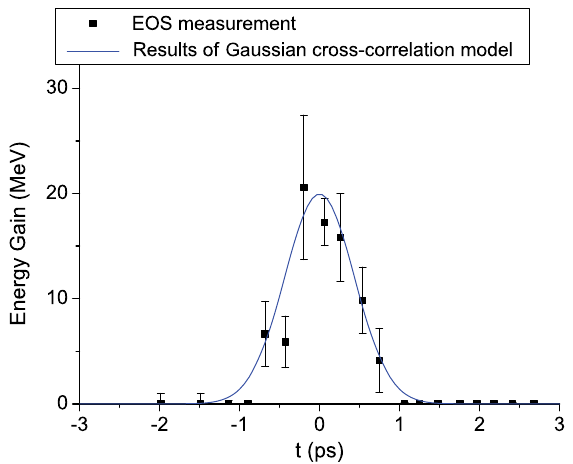
FIG. 8. Results of time of arrival study. Over 200 correlated relative time of arrival and spectrometer images were sampled and binned to provide the temporal overlap profile of the IFEL interaction. The solid curve is the result of the cross-correlation model assuming Gaussian laser and electron temporal profiles with 50 fs and 240 fs rms durations,